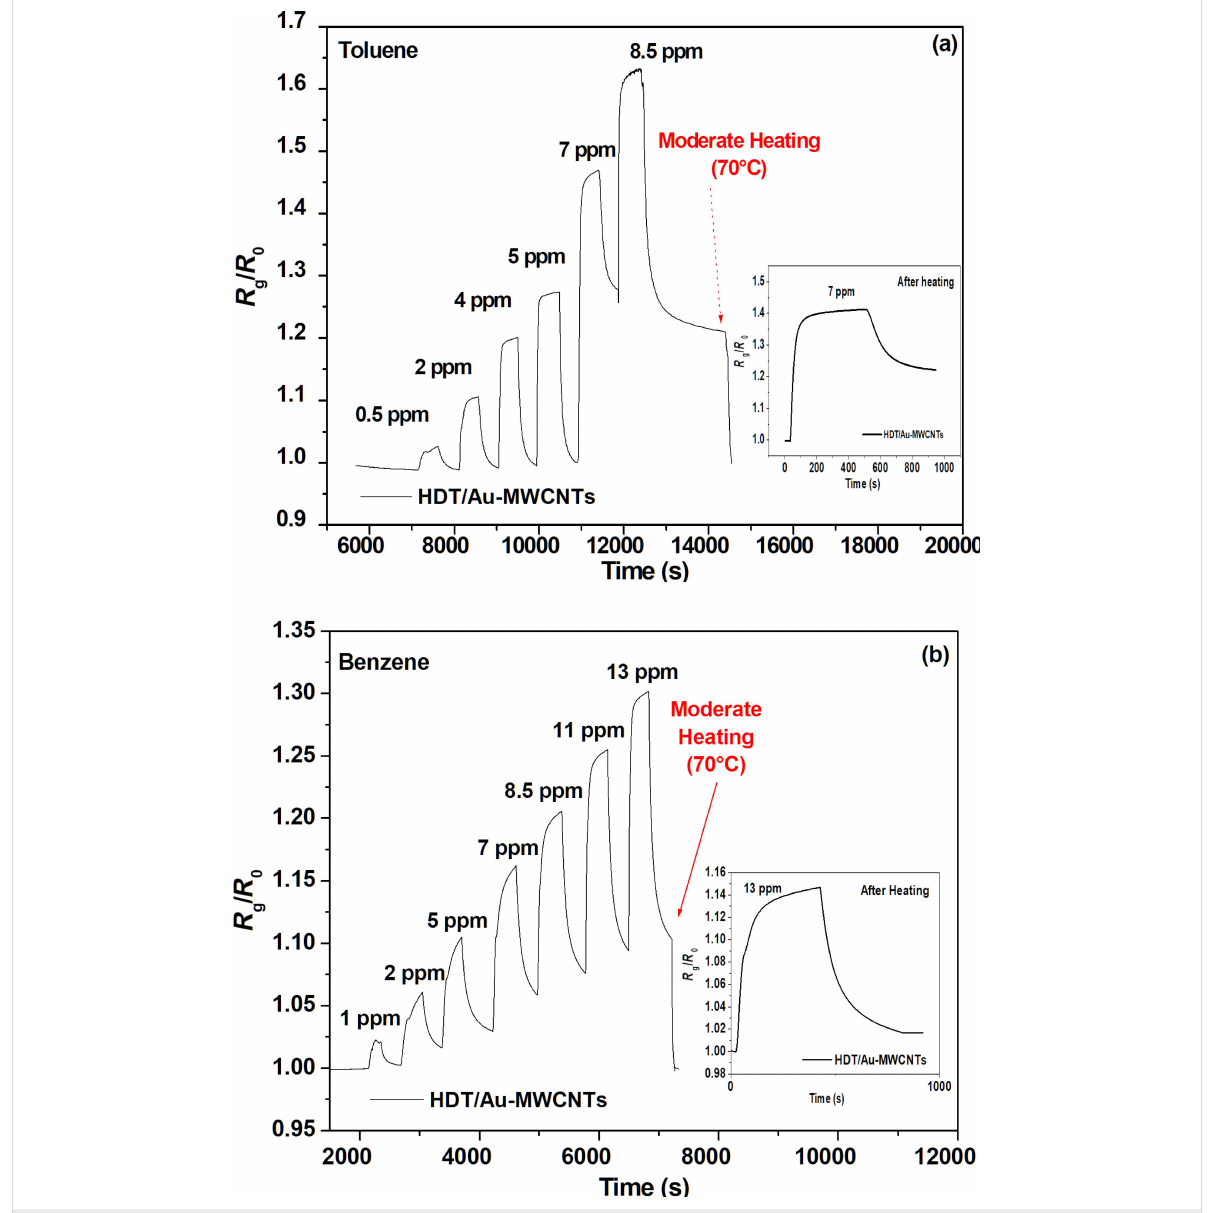
Figure 5: HDT/Au-MWCNT sensor responses for different concentrations of the injected vapours of (a) toluene and (b) benzene.